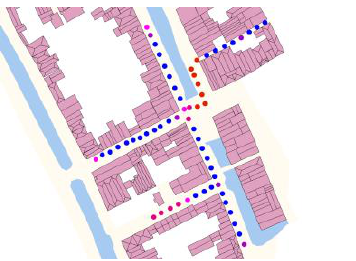
Figure 2. Satellite visibility percentage in Delft (Verbree et. al., 2004) Taylor et al. (2007), meanwhile, established a DSM model that merged aerial photography and LiDAR into a realistic digital surface model to calculate the Line of Sight (LOS) vector. As shown in Figure 3, the green lines represent visibility and the red lines invisibility. Using LOS can thus determine the status between satellites and stations and aid decisions on whether to perform GPS surveying.